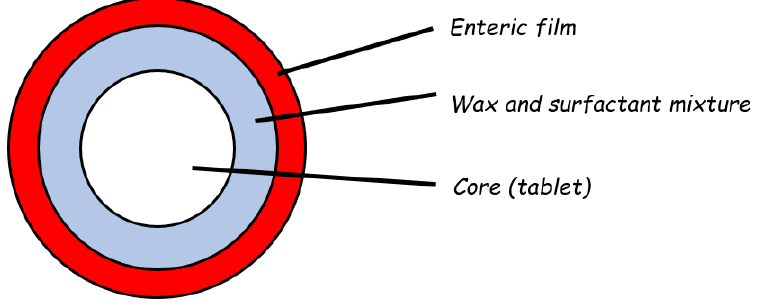
Figure 12. Schematic representation of the Time Clock ® system. Adapted with permission from Ref. [50]. 1994, Elsevier. Table 4. GI transit times (min), tablet dispersion time (min) and tablet dispersion site of placebo units — six fed (light breakfast) volunteers. Adapted with permission from Ref. [51]. 1994, Elsevier.